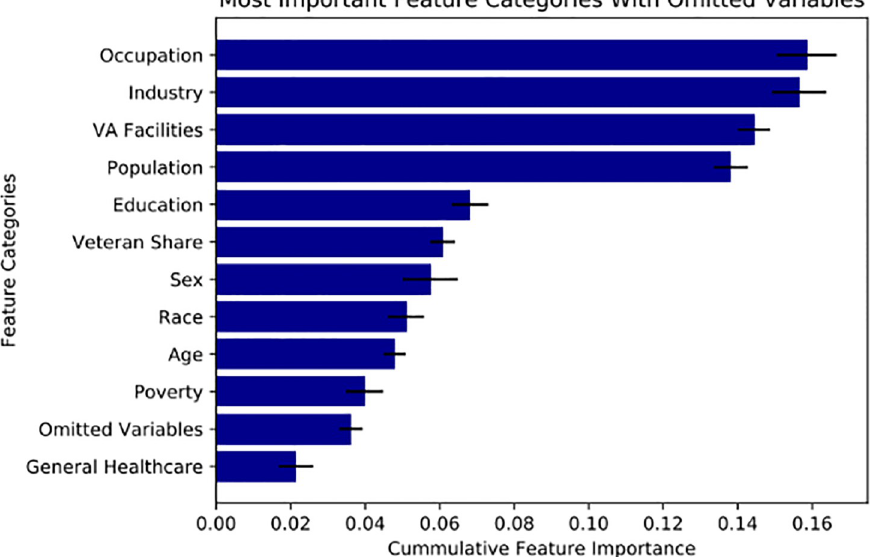
Fig 4. Feature categories importance with omitted variables for PPP loans to Veterans. Notes.— Feature Importances are given by an XGBoost model trained on the Zipcode Demoraphics and VA Facility Dataset with new Omitted Variables. The dataset includes features pertaining to zipcode level demographic data, access and quality of care of the closest local and large regional VA Medical Centers, and new omitted varaibles. The Feature Category figure plots the importance of Feature Categories by the cumulative importance of the features in each category. The error bars represent one standard deviation from the mean importance.